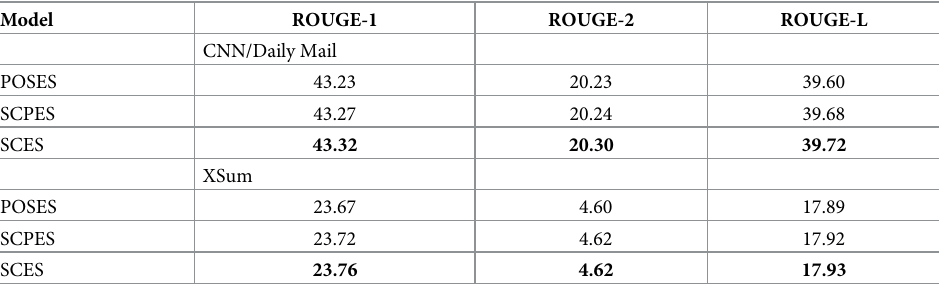
Table 3. Performance difference caused by different sentence information.